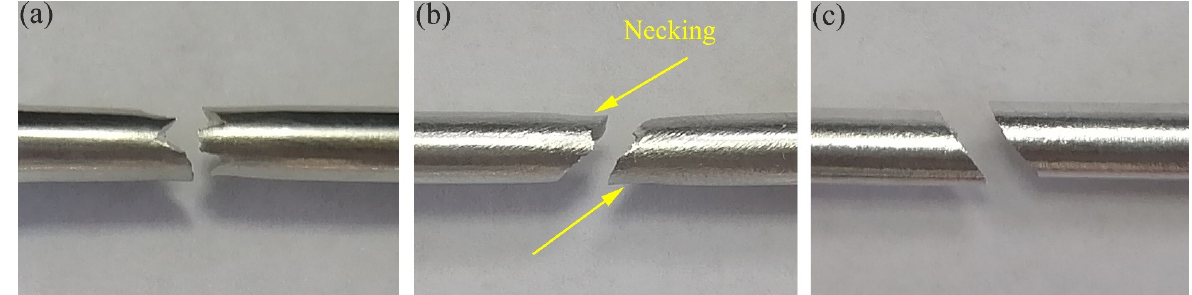
Figure 7. Macroscopic fracture morphologies of extruded 7075 Al alloy in different directions: ( a ) ED, ( b ) 45°, ( c ) RD. Figure 8 is an enlarged view of the tensile fracture in the three directions. For all specimens, there are a lot of dimples and cleavage planes in the fracture surface, which can be considered as a mixed mode of intergranular fracture and transgranular fracture. Due three directions is different, which shows the anisotropy of the mechanical properties [24].